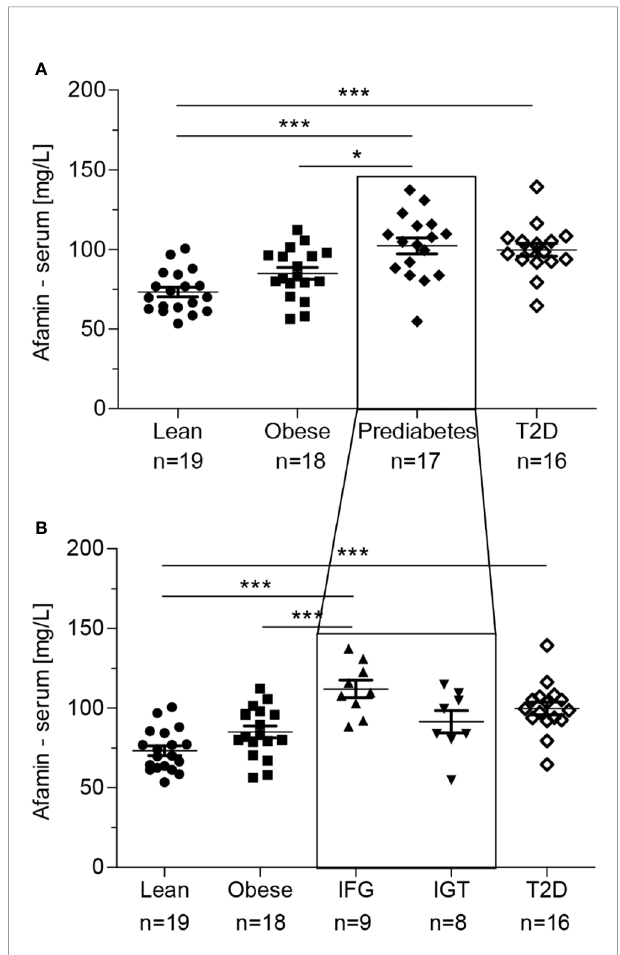
FIGURE 1 | (A) Serum afamin concentrations in individuals with obesity, prediabetes and type 2 diabetes (T2D). (B) The group with prediabetes was divided into IFG (Increased Fasting Glucose) and IGT (Impaired Glucose Tolerance). Data are presented as mean ± SEM. *p < 0.05; ***p <